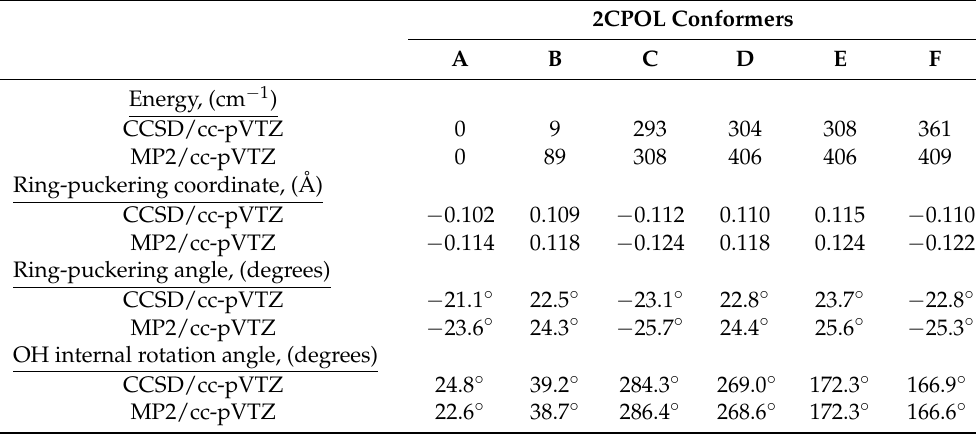
Table 5. Comparison of calculated conformational energies and geometrical parameters for 2CPOL from CCSD/cc-pVTZ and MP2/cc-pVTZ